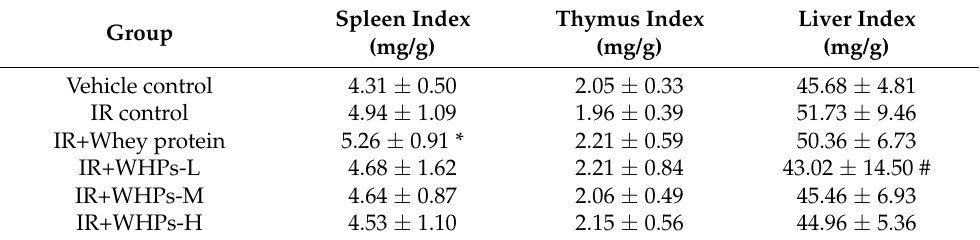
Table 5. Effects of WHPs on organ index in irradiated mice at day 14 after radiation ( n = 12, x ± s).